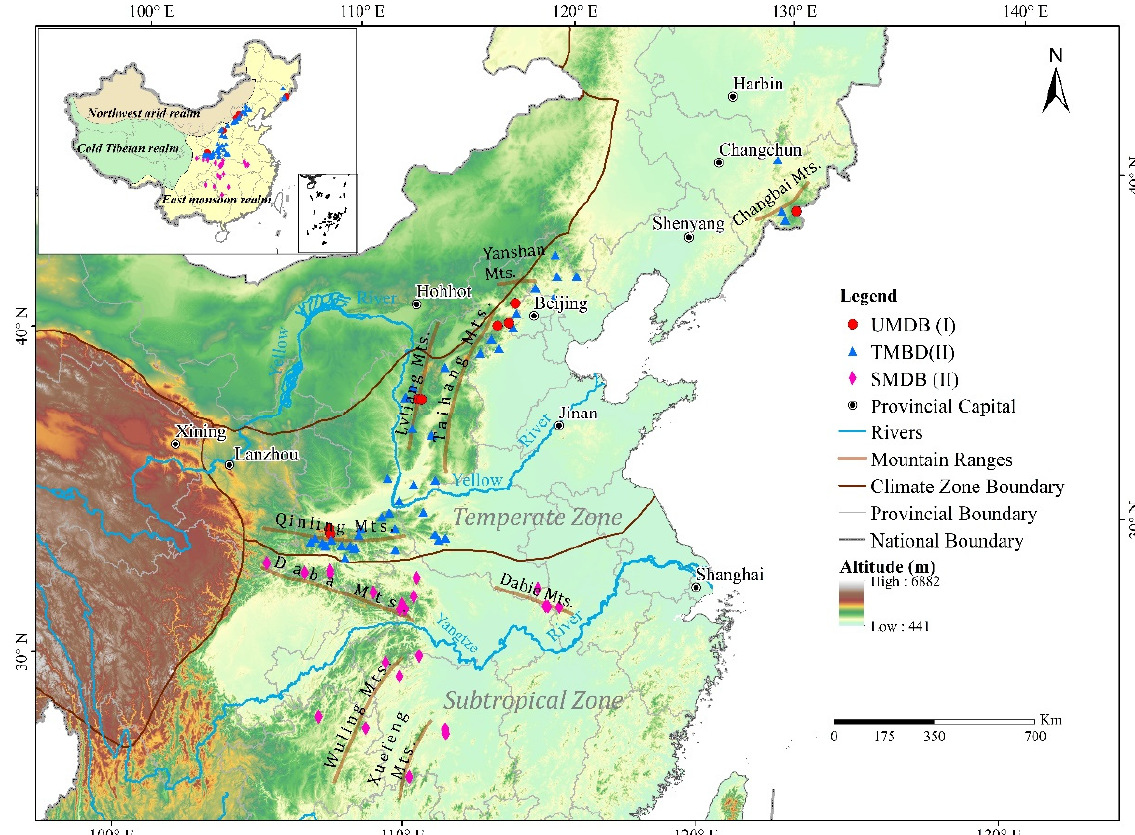
Figure 1. The upper limit of montane deciduous broad-leaved forest in the east monsoon realm of China. Abbreviation: UMDB (I), 8 upper limits of deciduous broad-leaved forest on the mountains with climatic treeline; TMDB (II), 45 upper limits of deciduous broad-leaved forests on the temperate mountains without climatic treeline; SMDB (II), 22 upper limits of deciduous broad-leaved forest on the subtropical mountains without climatic treeline.